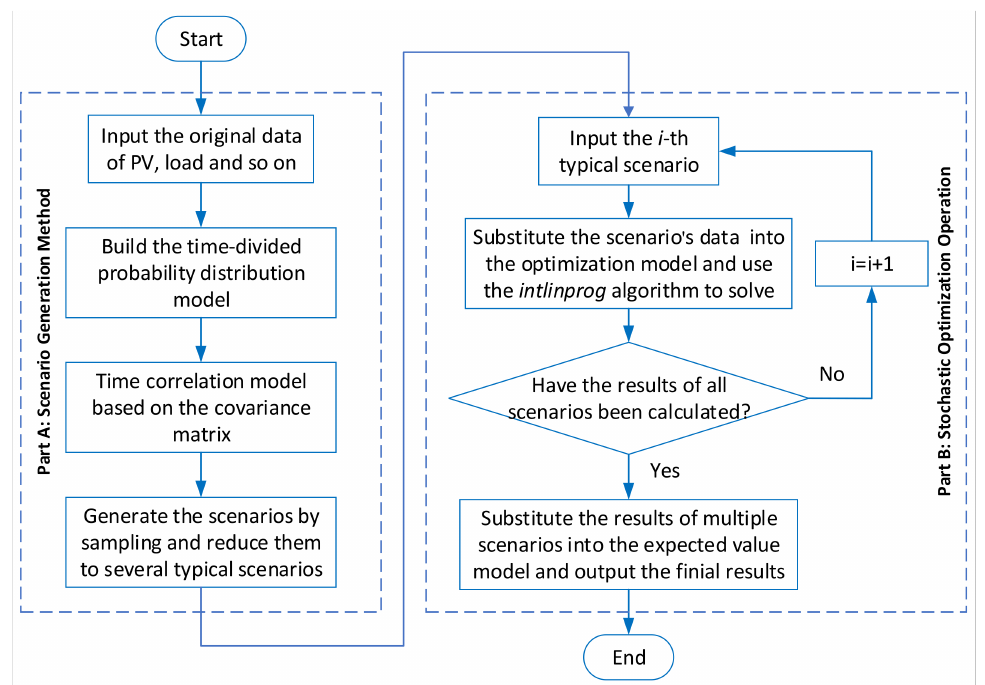
Figure 2. The flow chart of solving method.